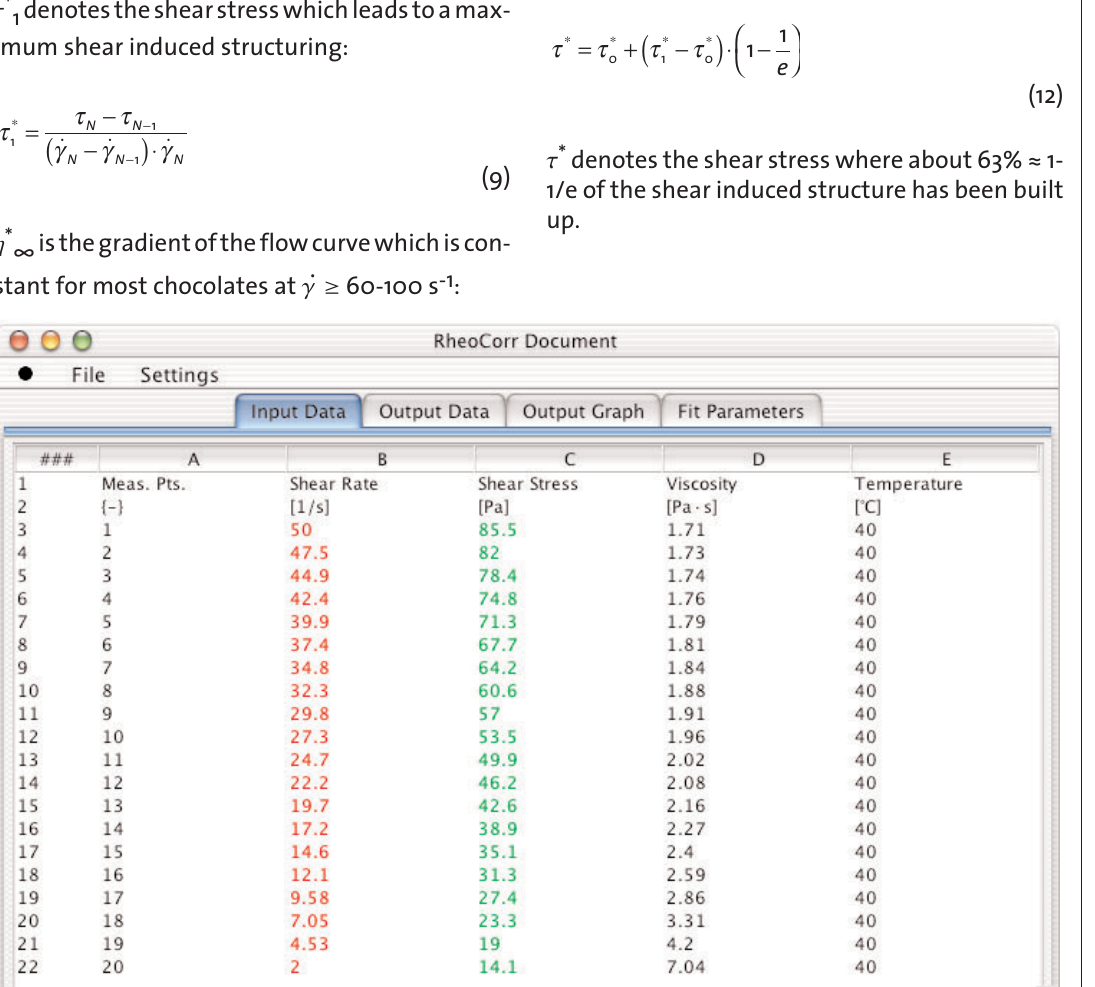
Figure 1: Input data spread-